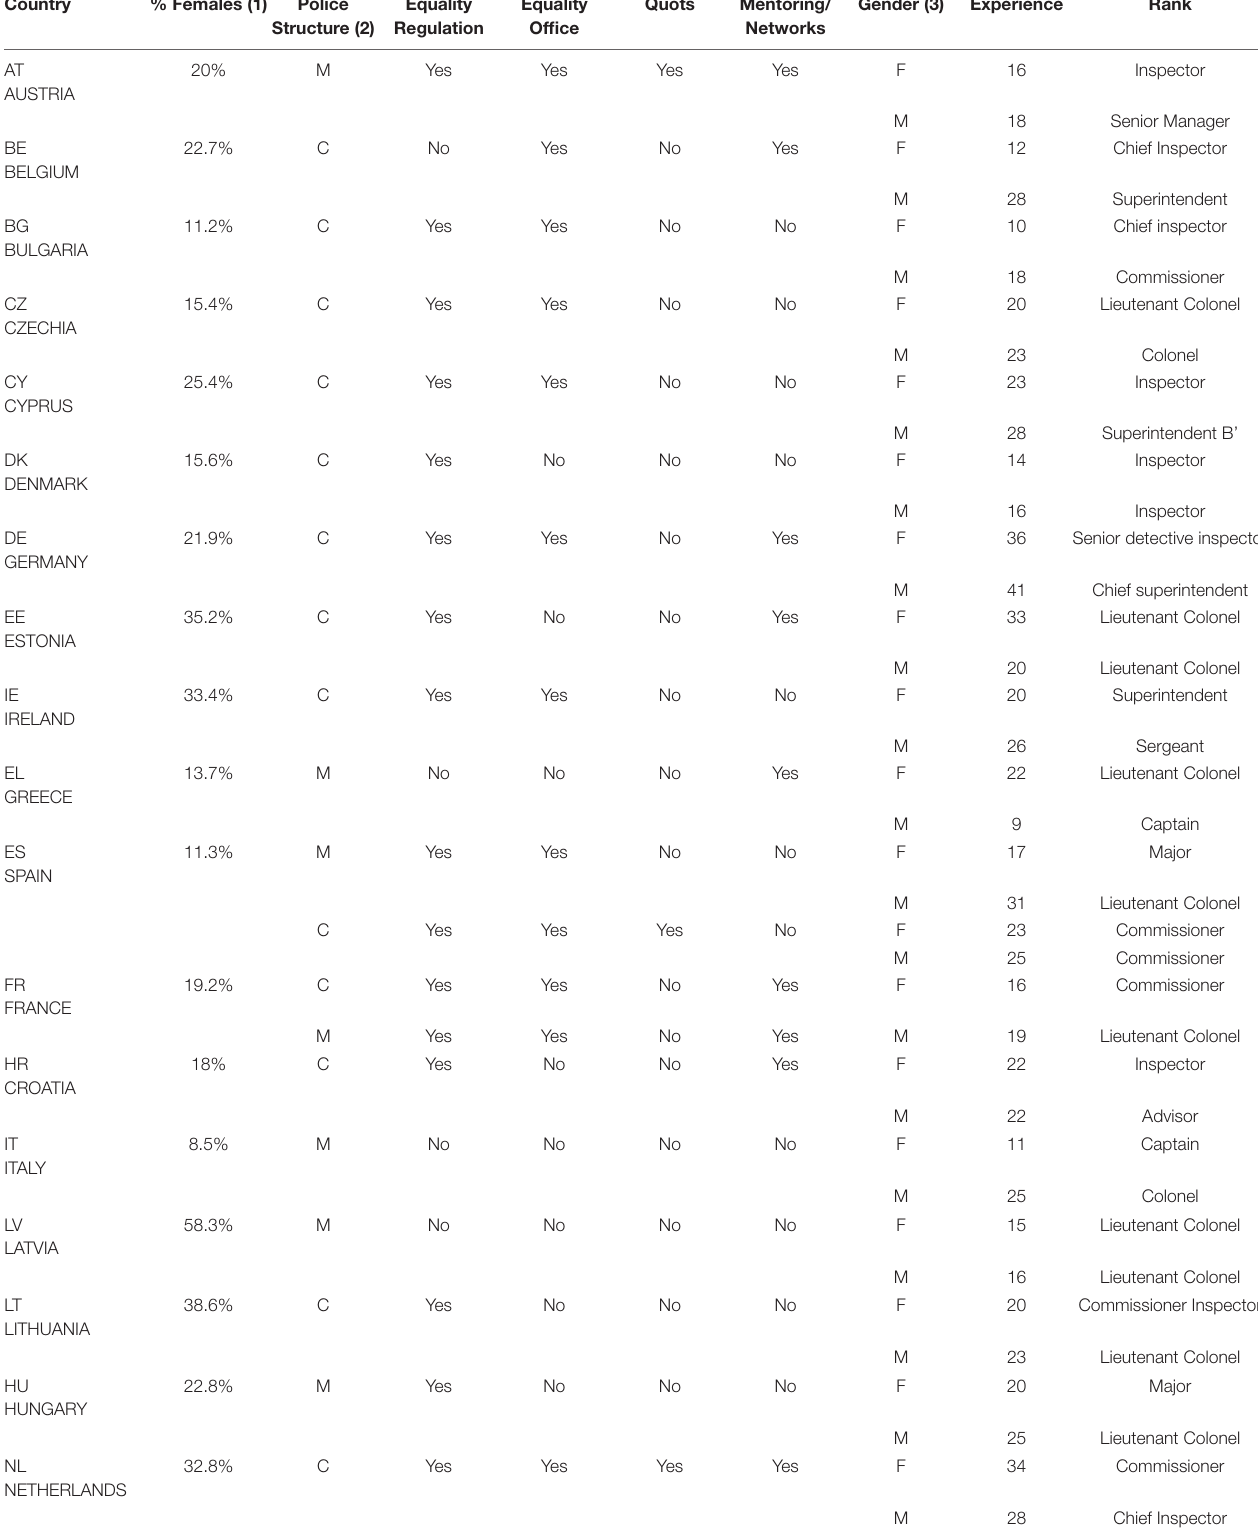
TABLE 1 | List of countries, police forces’ characteristics and respondents. Country % Females